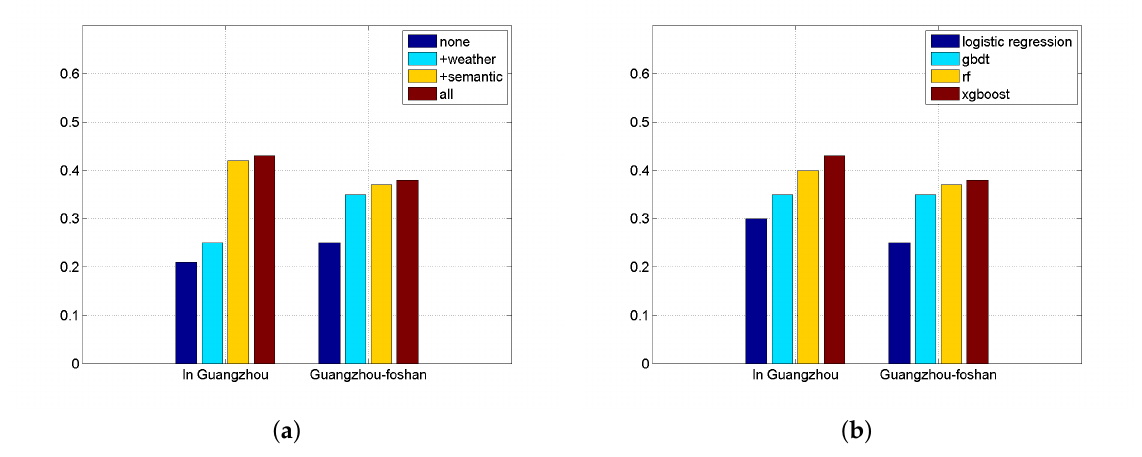
Figure 7. F1 scores of passenger boarding choice forecasting. ( a ) Features; ( b ) Models.